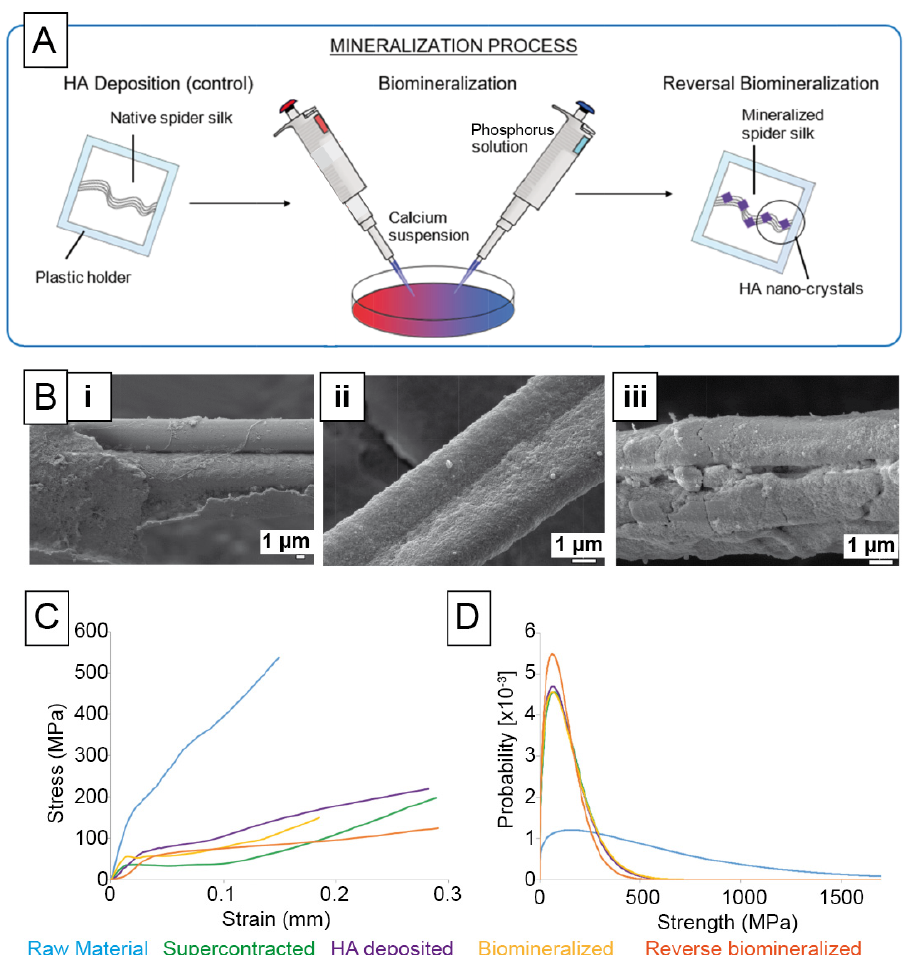
Figure 7. ( A ) Schematic illustration of the mineralization process of natural Cupiennius salei spider silk fibers. ( B ) Scanning electron microscopy images of mineralized silk fibers after ( i ) 1 day of biomineralization and day 3 ( ii ) and 7 ( iii ) of reversal biomineralization. Mechanical characterization of fibers in ( C ) stress-strain plots and ( D ) Weibull probability distribution as parameter for homogenous fracture behavior. HA = hydroxyapatite. Reprinted and adopted with permission from ref.